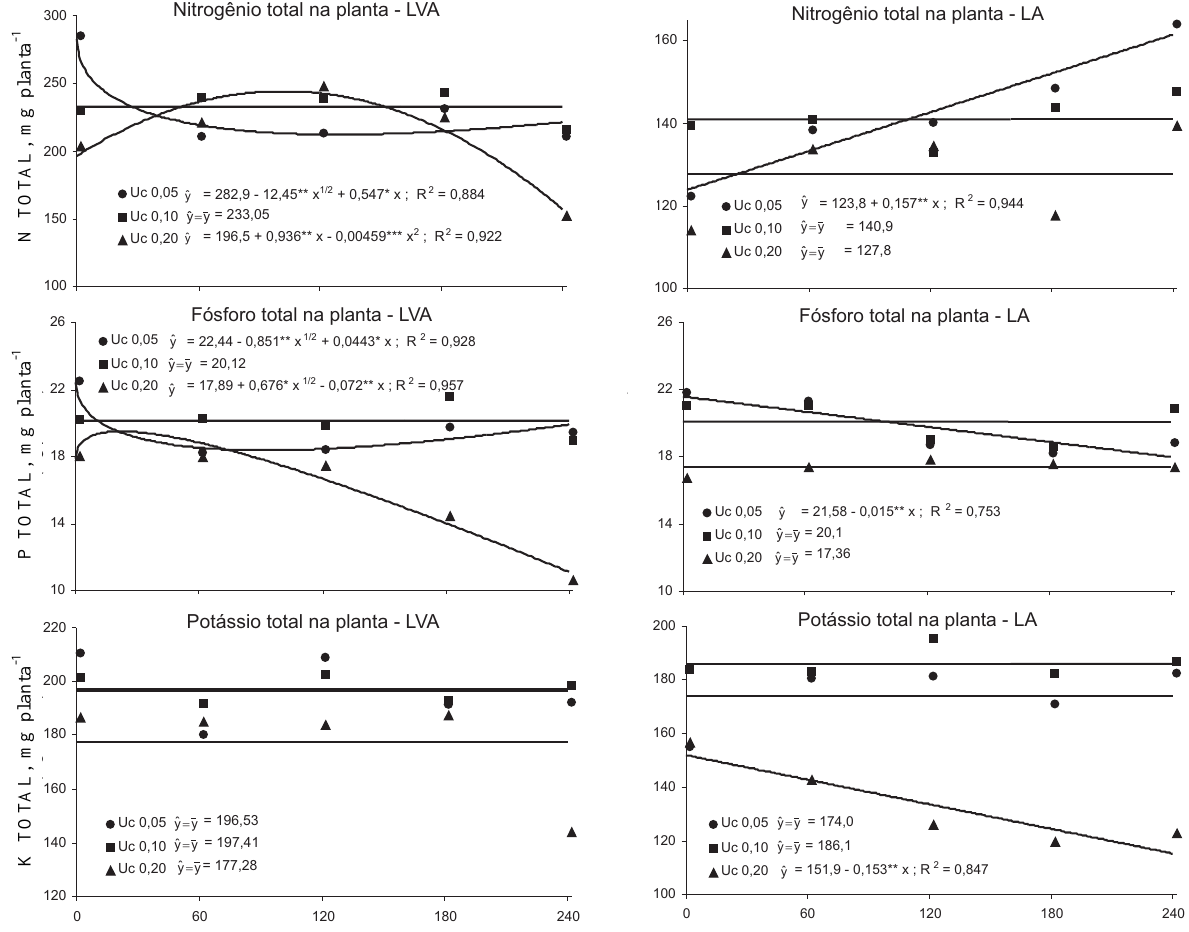
Figura 3. Conteúdos de nitrogênio, fósforo e potássio na matéria seca total de eucalipto em dois Latossolos compactados com diferentes pressões e